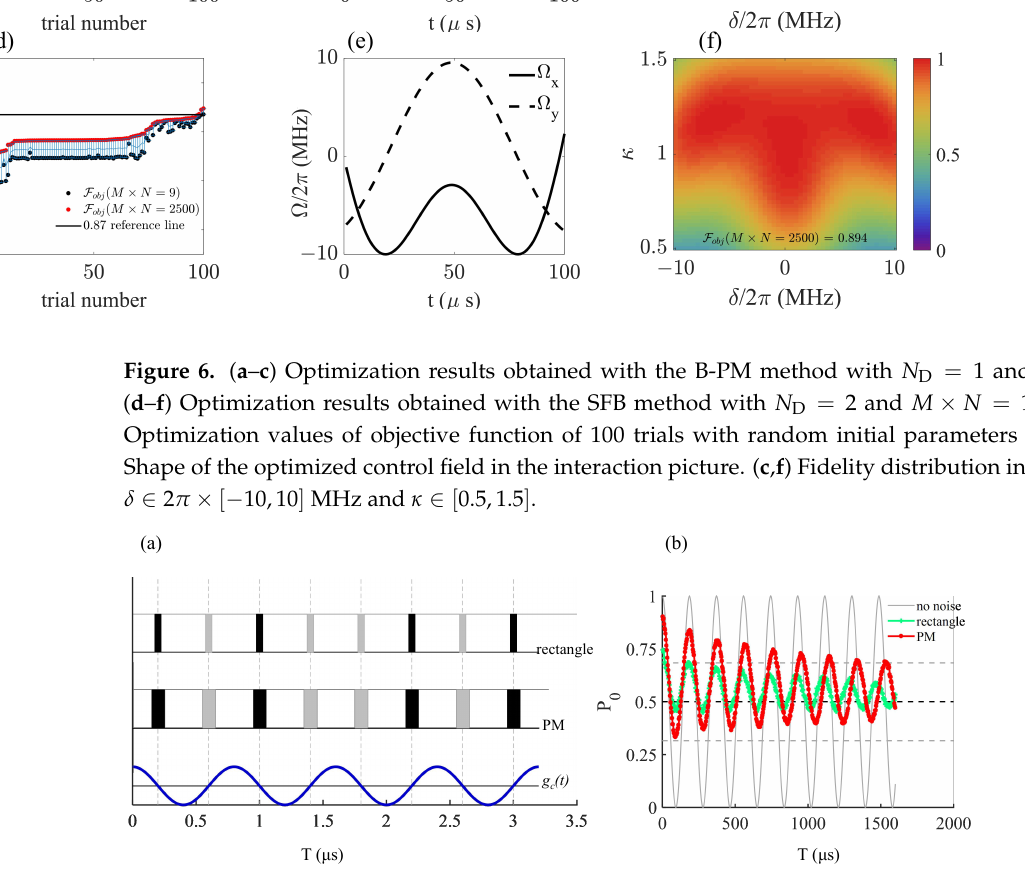
Figure 7. ( a ) Scheme of XY-8 pulse and AC signal to be sensed. The pulse length of the rectangular pulse was T pulse = 50 ns, and that of the PM pulse was T pulse = 100 ns. The time separation for the rectangular pulse was τ = 350 ns, and that for the PM pulse was τ = 300 ns. The frequency of the AC signal was ω s = π / ( T pulse + τ ) = 2.5 π MHz. ( b ) Simulation results of the population of | 0 (cid:105) of the NV center ensemble using different XY-8 pulses. Red line with point marks: population under optimized pulse obtained with the B-PM method with pulse length T pulse = 100 ns. Green line with cross marks: population under rectangular π pulse with pulse length T pulse = 50 ns. Gray solid curve: population under rectangular π pulse with pulse length T pulse = 100 ns without considering inhomogeneous broadening or the dynamic noise term. Gray dashed lines: from top to bottom, P 0 = ( 1 + 1/ e ) /2 reference, P 0 = 1/2 reference and P 0 = ( 1 − 1/ e ) /2 reference, respectively. The T 2 time was identified as the time when the maximal value of P 0 dropped below ( 1 + 1/ e )